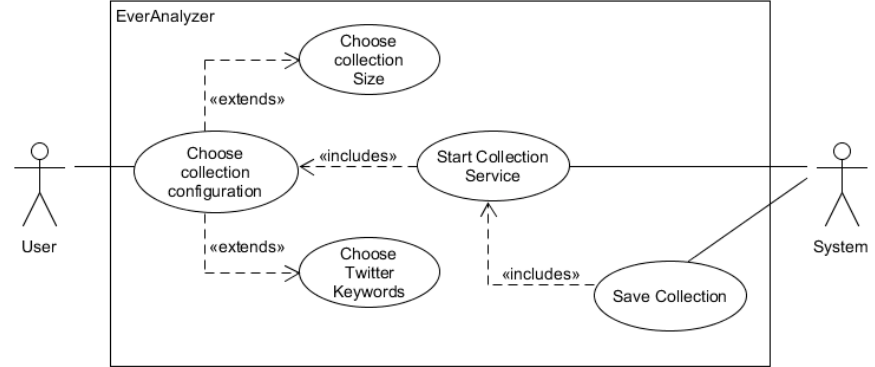
Figure 7. Use Case diagram of EverAnalyzer Objective #1.